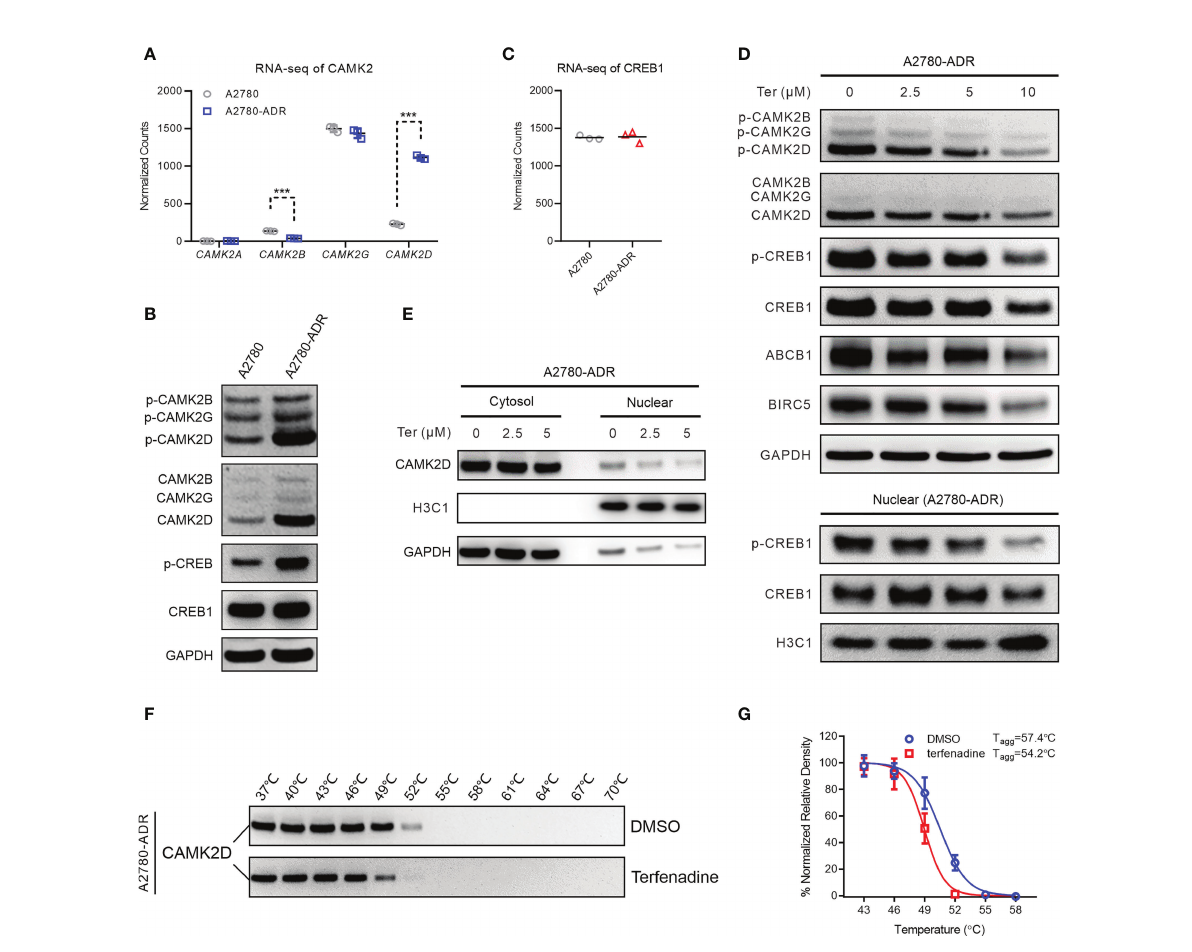
FIGURE 5 Terfenadine overcomes MDR in ovarian cancer cells by inhibiting the CAMK2/CREB-mediated pathway. (A) Normalized read counts of the CAMK2 family in MDR ovarian cancer cells and its parental sensitive ovarian cells (A2780) obtained in the RNA-seq analysis. (B) Western blot analysis of p- CAMK2 (T286), CAMK2 (pan), p-CREB1 (s133), and CREB1 in MDR sensitive ovarian cells (A2780). GAPDH was used as the loading control. (C) RNA- seq normalized read counts of CREB1 in MDR ovarian cancer cells and its parental sensitive ovarian cancer cells A2780. (D) Upper panel: Western blot analysis of p-CAMKII (T286), CAMKII (pan), p-CREB1 (s133), CREB1, ABCB1, and BIRC5 in MDR ovarian cancer cells treated for 24 hours with terfenadine (Ter). GAPDH was used as the loading control. Lower panel: Western blot analysis of CREB1 and p-CREB1 (s133) in the nucleus of MDR ovarian cancer cells treated with terfenadine (Ter) for 6 h. Histone H3 (H3C1) was used as the loading control. (E) Western blot analysis of CAMK2D in the cytosol or nucleus of terfenadine (Ter)-treated MDR ovarian cancer cells for 6 hours. GAPDH and H3C1 were used as the loading controls for cytosol protein and nucleus protein, respectively. (F , G) Cellular thermal shift assay (CETSA) for the binding of terfenadine to CAMKIID in MDR ovarian cancer cell lysate. (F) Representative western blot images for the CESTA. (G) T agg curves of CaMKIID in MDR ovarian cancer cells in the presence of DMSO or 600 µM of terfenadine. All statistical analysis was performed using a two-tailed t-test (*** p <